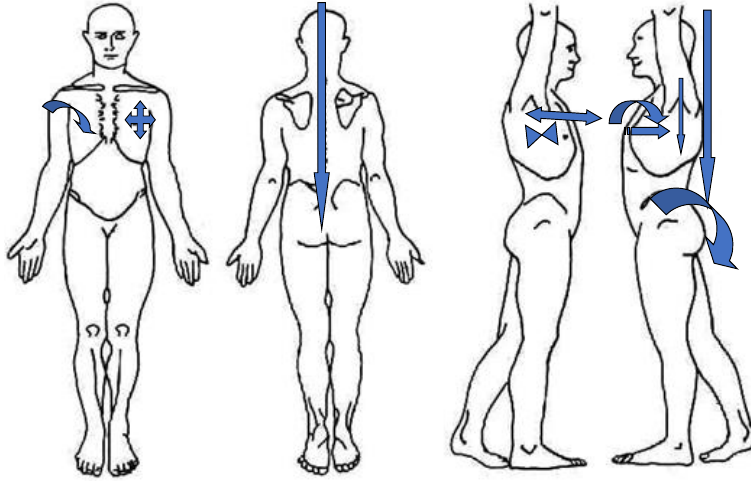
Figure 2 . Inward motions of attention in religious